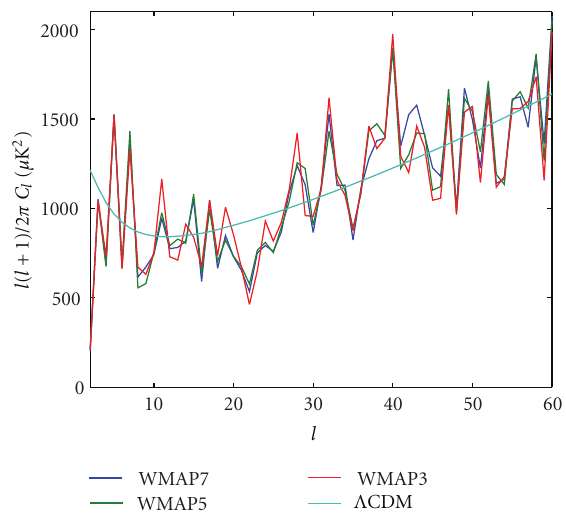
Figure 1: CMB power spectrum: WMAP 7 year data (blue), WMAP 5 year data (green) and WMAP 3 year data (red), Λ CDM model (cyan). Figure 2: ( − 1) l × di ff erence between WMAP power spectrum data and Λ CDM model.